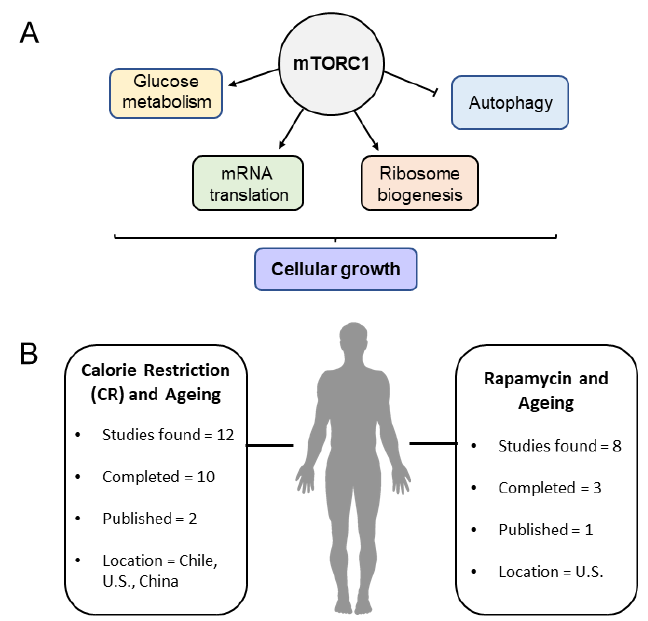
Figure 2. Schematic of mTORC1-regulated processes ( A ) and summary of clinical trials related to mTORC inhibition and calorie restriction ( B ). Table 1. Summary and information on clinical trials using Rapamycin-related interventions in human aging studies (summarized in Figure 2B) including study status, interventions and number of participants. Information gathered from www.clinicaltrials.gov, accessed on 17 March 2022.